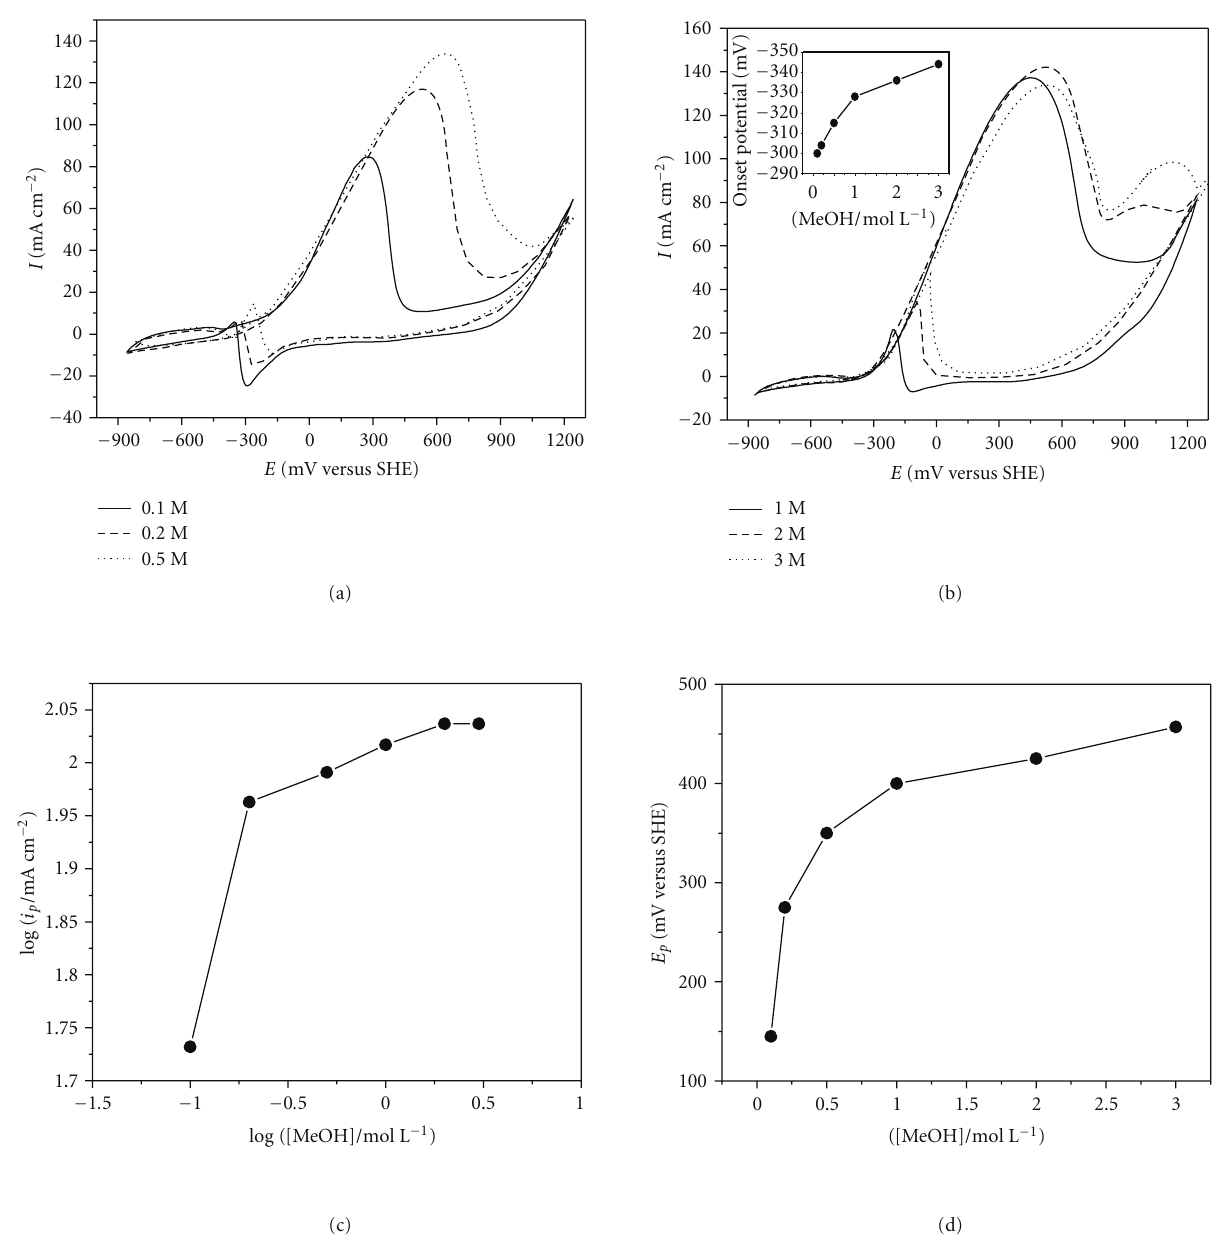
Figure 5: (a) and (b) Cyclic voltammograms for methanol oxidation on Pt-Pd/C electrode in 0.5MNaOH at various methanol concen- trations at 25 ◦ C and sweep rate of 50 mVs − 1 . (b-Inset) Variation of onset potentials for methanol oxidation with methanol concentration. (c) Plot of log i p (peak current) versus log [MeOH] for methanol oxidation on Pt-Pd/C electrode in 0.5 MNaOH with various methanol concentrations. (d) Variation of anodic peak potential ( E p ) for methanol oxidation on Pt-Pd/C catalyst with methanol